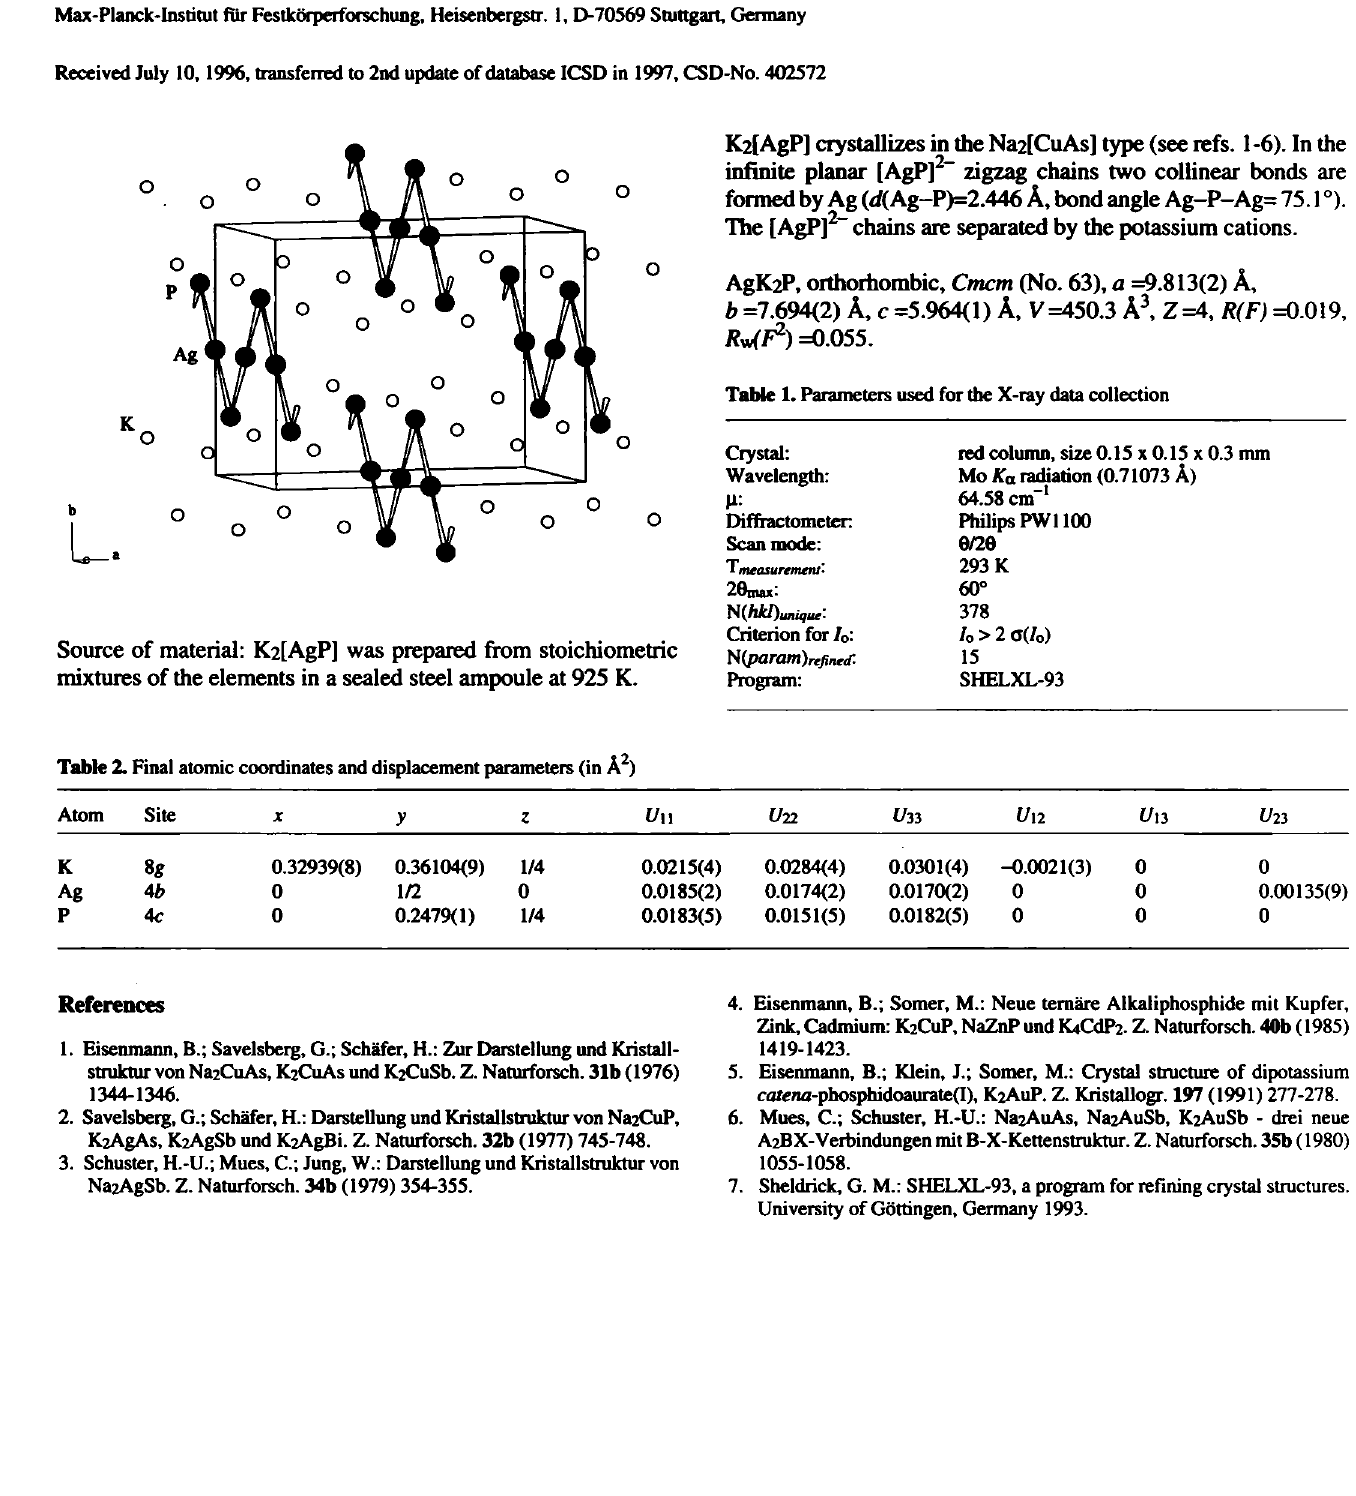
Source of material: K2 [AgP] was prepared from stoichiometric mixtures of the elements in a sealed steel ampoule at 925 K.